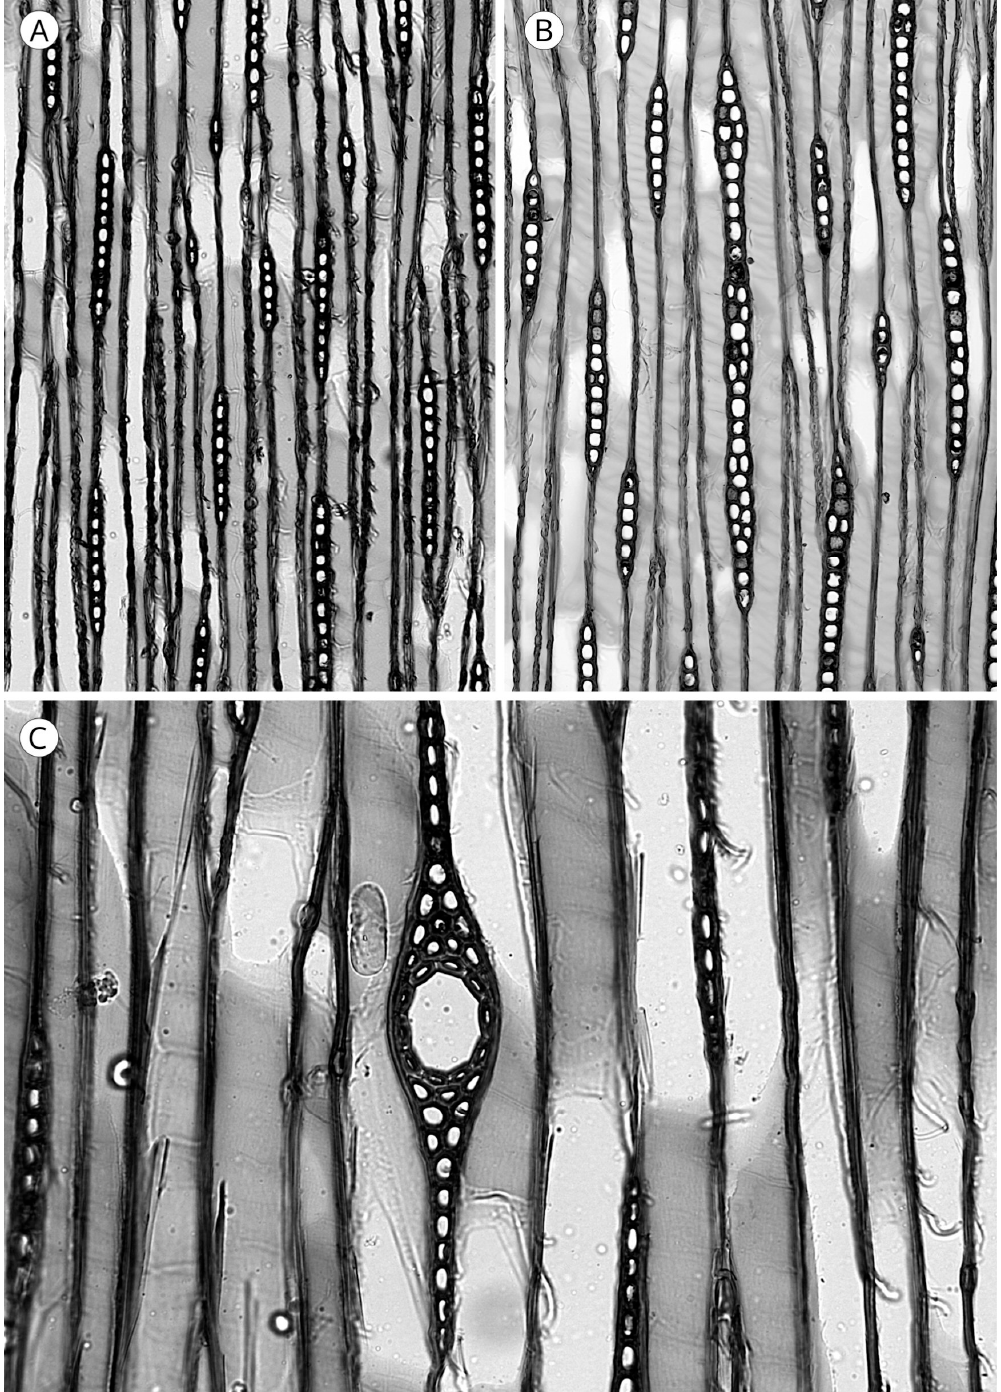
Figure 28. Ray width. ( A ) Uniseriate in Abies numidica de Lannoy ex Carrière; ( B ) Biseriate in Cedrus atlantica (Endl.) Manetti ex Carrière; ( C ) Fusiform in Picea alcoquiana (H.J.Veitch ex Lindl.) Carrière. Scale bars. ( A – C ) = 100 μ m.